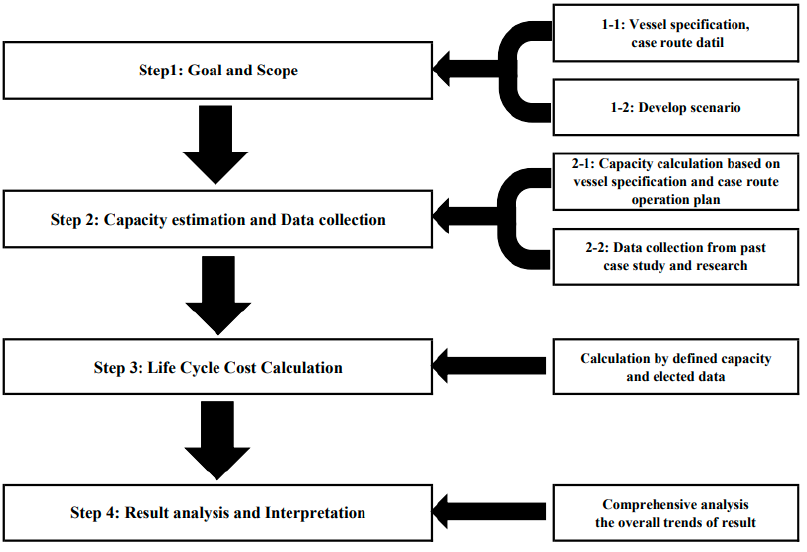
Figure 1. Flowchart of methodology.